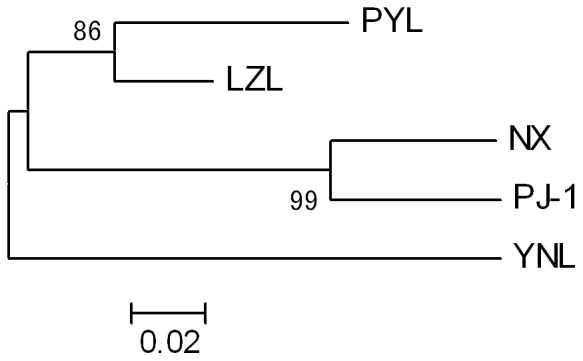
NJ dendrogram of relationships among blunt snout bream populations based on Nei's unbiased genetic distance.Percent bootstrap support values for 10,000 replications are indicated at nodes. See Table 1 for population abbreviation definitions.